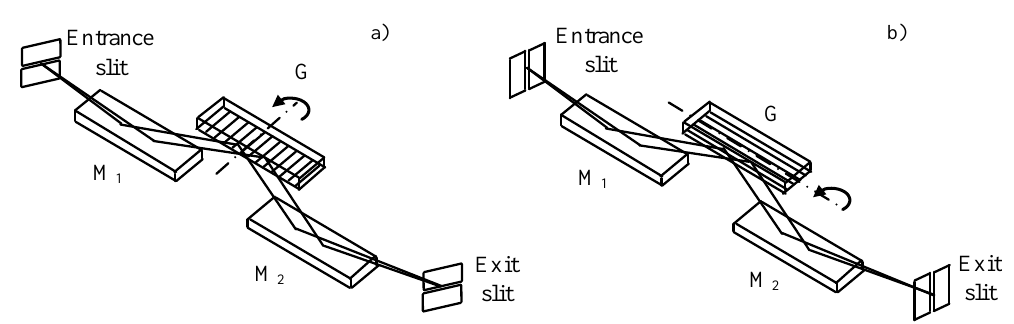
Figure 2. Monochromator with plane gratings: ( a ) CDM; ( b ) OPM. M 1 and M 2 are respectively the collimating and focusing mirror, G is the grating.